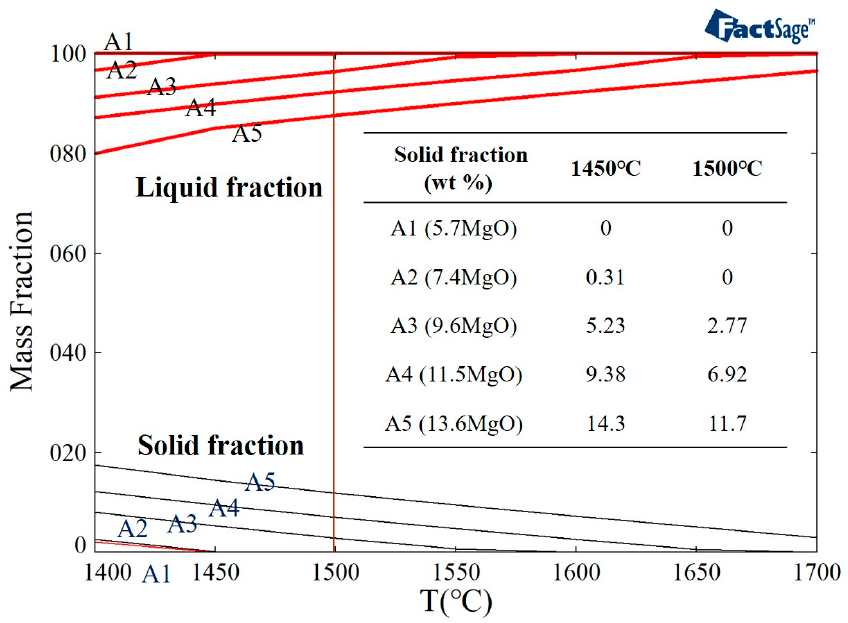
Figure 3. FactSage simulation of the solid phase fraction of different slag samples.